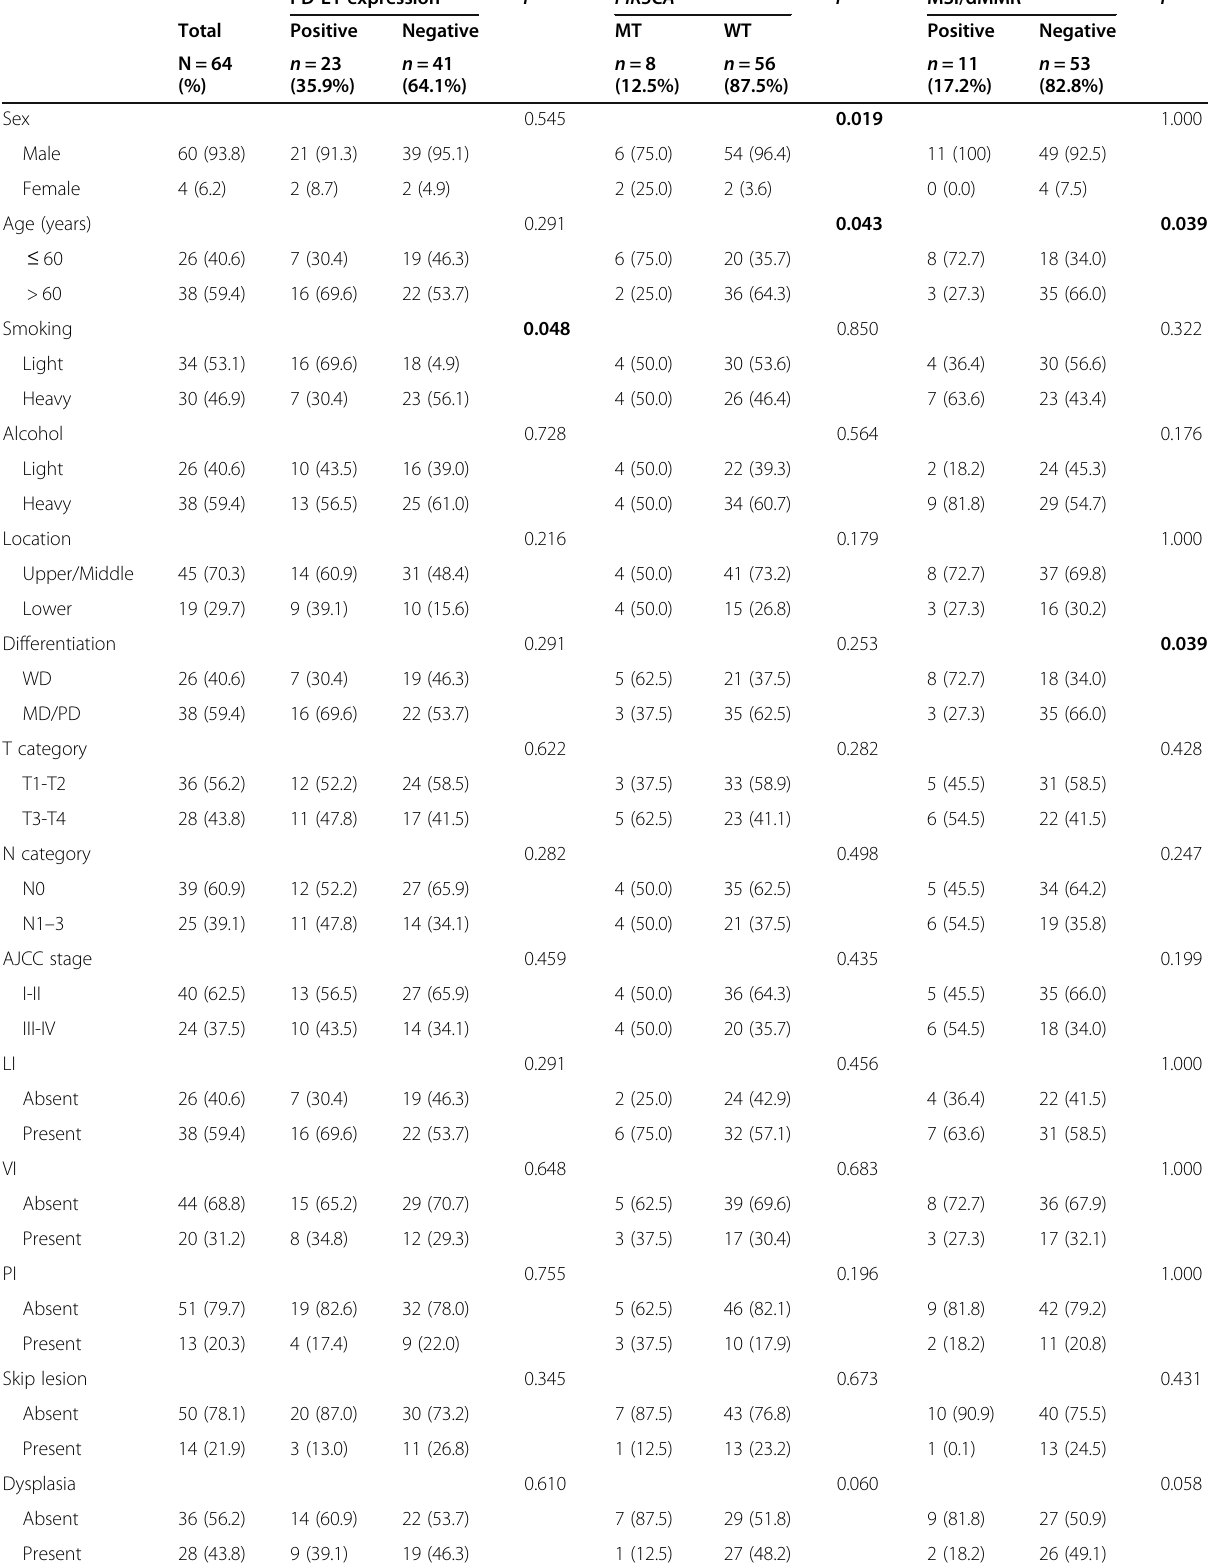
Table 2 Clinicopathologic correlations of PD-L1 expression, PIK3CA mutation, and MSI/dMMR